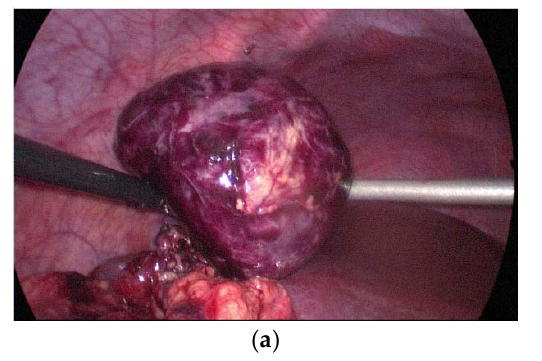
Figure 4. Whole-body PET scan showing: ( a , b ) persistent focal increase in FDG uptake in the right upper abdomen (early/delayed SUV max = 2.2/2.3) and a tumor or inflammation was pointed out <red duplex and arrow>. SUV = standard uptake volume.